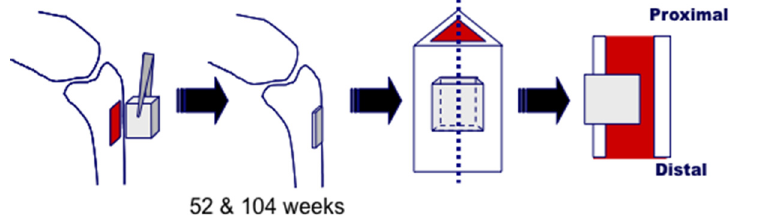
Figure 10. Schematic diagram of the implantation procedure and preparation of samples for histological